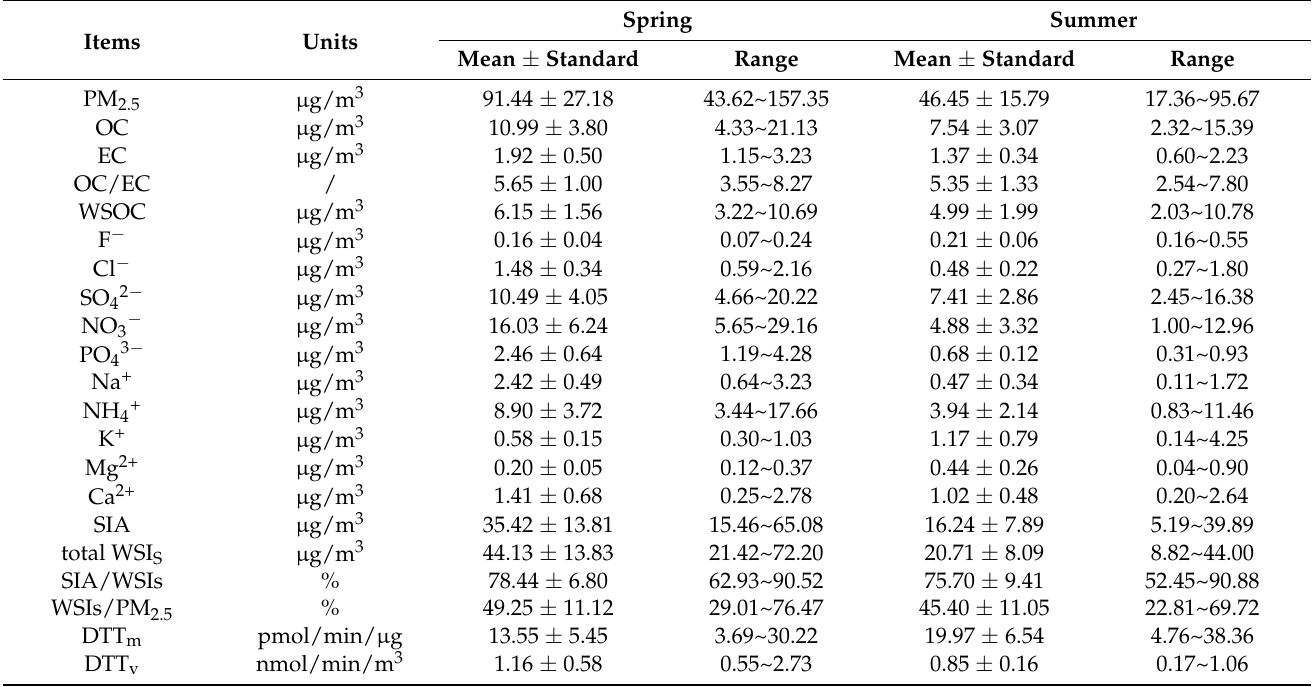
Table 1. Concentration range and mean ± standard deviation concentrations of PM 2.5 and its chemical